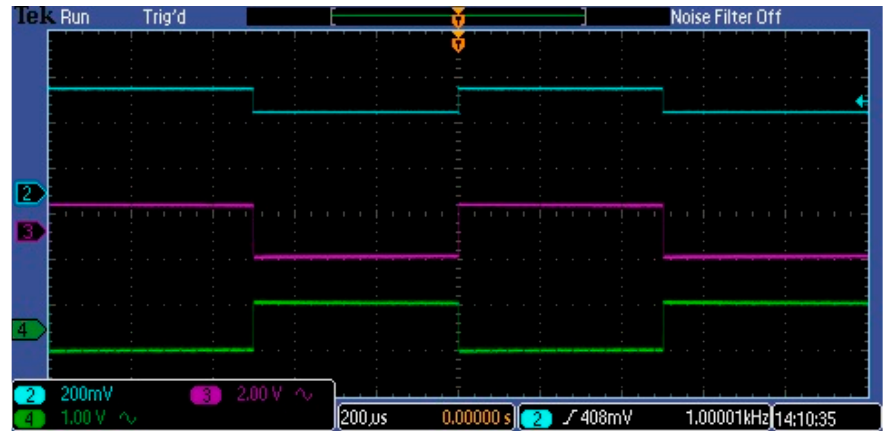
Figure 15. Amplified pulse waveforms at 1 kHz. Figure 16. Amplified pulse waveforms at 100 kHz.